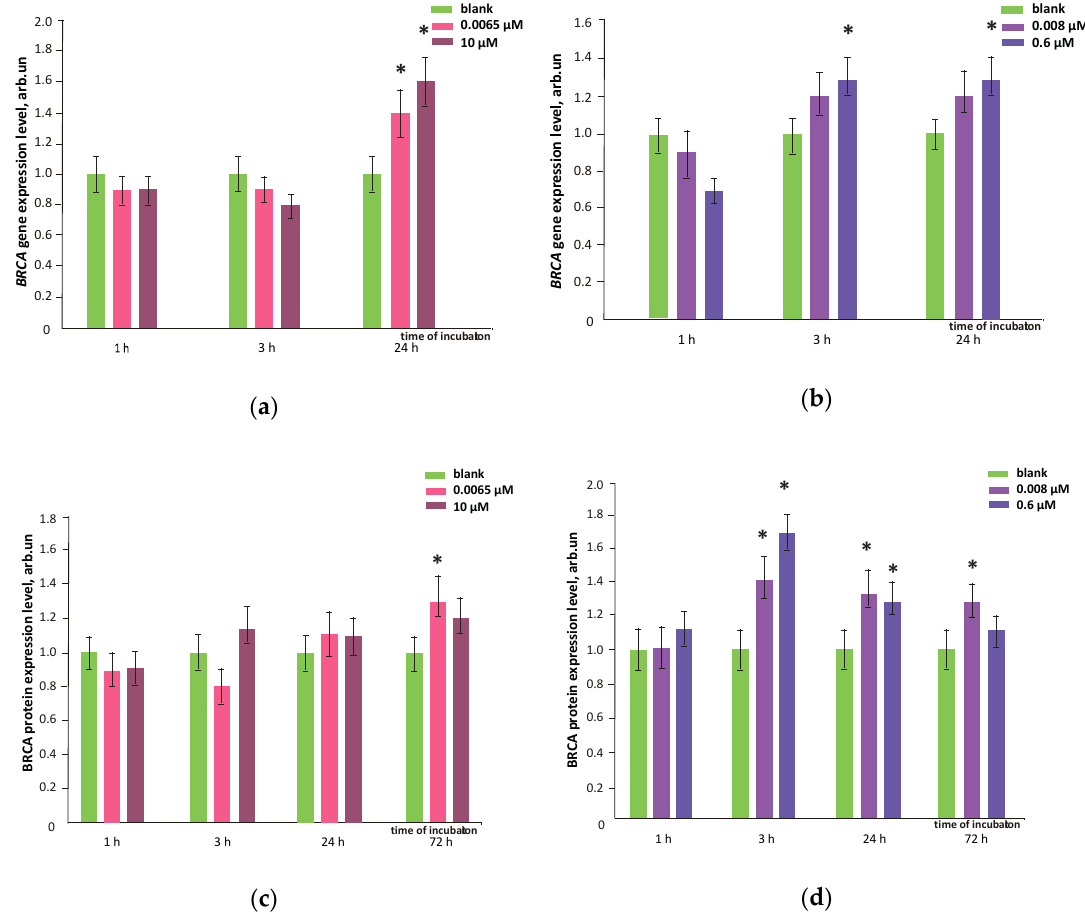
Figure 13. BRCA1 gene expression in HFLF cells caused by ( a ) FF1 and ( b ) FF2; BRCA1 protein levels in HFLF treated with ( c ) FF1 and ( d ) FF2 relative to blank (concentrations are shown in the figure). The mean of BRCA1 RNA amount of three experiments in relation to blank (BRCA1 gene expression in the cells with no fullerenes added). TBP gene was used as an internal reference gene. (*) marks significant differences in comparison with the blank, p < 0.01, nonparametric U- test. In blank experiments, cells were incubated without the fullerenes.